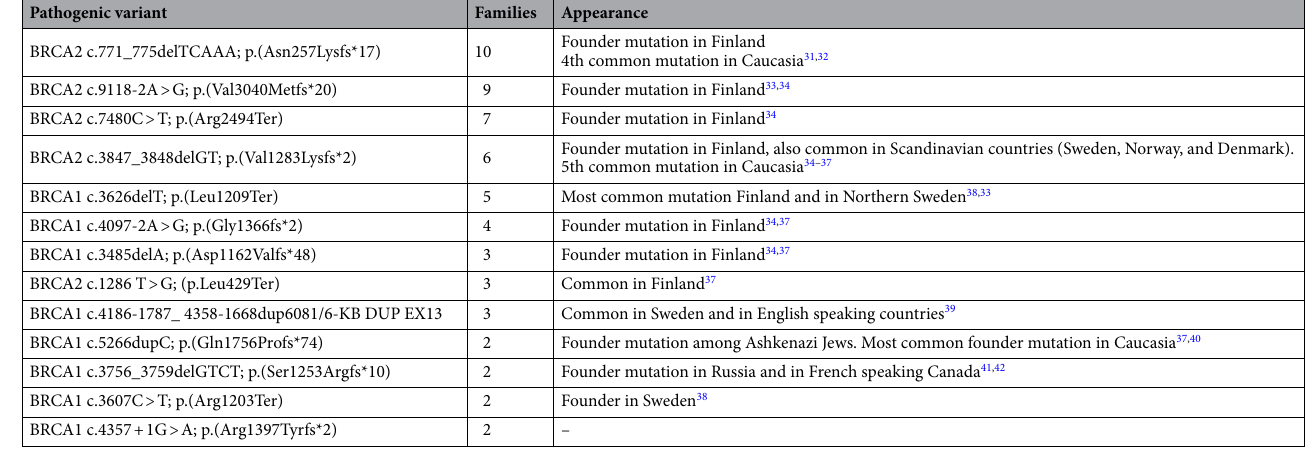
Table 10. Most common and founder BRCA1 and BRCA2 pathogenic variants in southwestern Finland and their appearance in other countries.